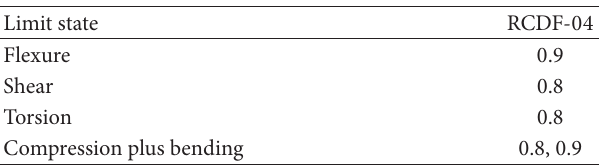
Table 2: Resistance factors, 𝜙 .